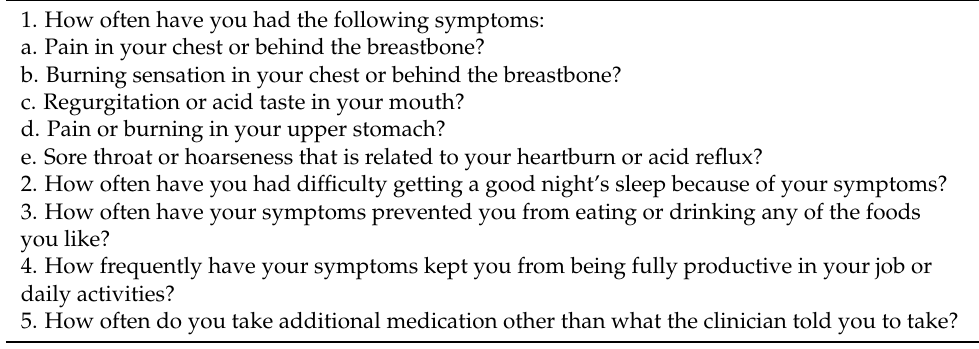
Table 1. Questions of the GERD Impact Scale (GIS).